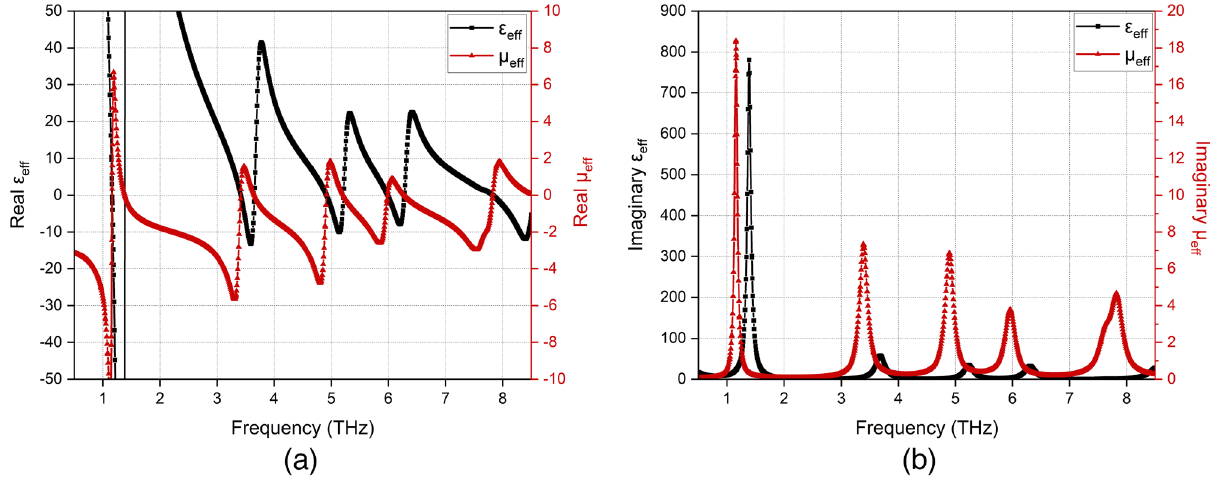
Figure 5. Calculated effective medium parameters: ( a ) Real parts of ǫ eff and µ eff ( b ) Imaginary parts of ǫ eff and µ eff .